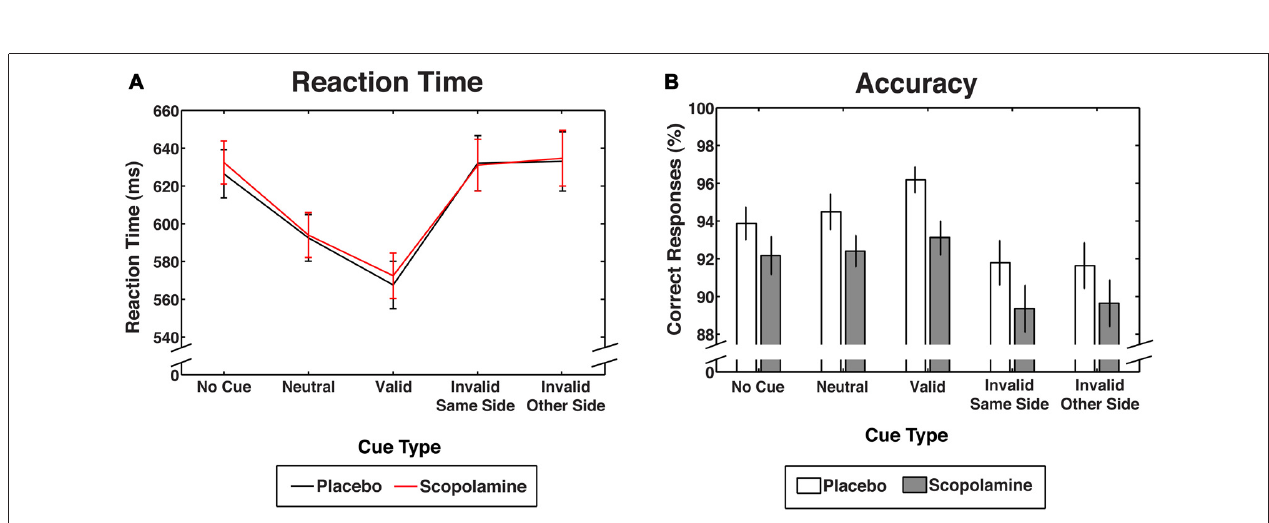
FIGURE 3 | Performance measures for contingent capture under placebo and scopolamine conditions. (A) Reaction times (RTs) in milliseconds (ms) for each cue condition. (B) Accuracy as percentage (%) of correct responses for each cue condition. All measures are displayed as group means with ± 1 standard error; n =